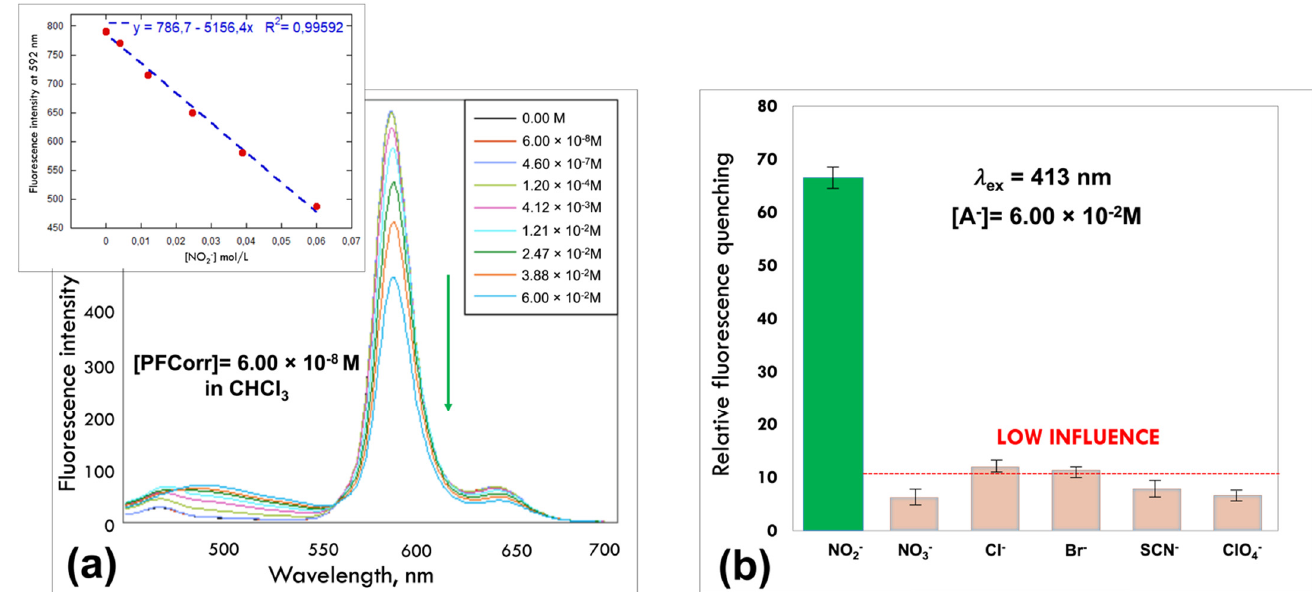
Figure 3. ( a ) The fluorescence response of 6 × 10 − 8 M PFCorr in CHCl 3 upon addition of increasing concentrations of NO 2 − ions. In the insert: linear regression curve of PFCorr fluorescence intensity quenching at 592 nm vs. [NO 2 − ], mol/L; ( b ) The tests on relative fluorescence quenching of PFCorr fluorescence at 580 nm in the individual anion solutions in concentration 6 × 10 − 2 M; 𝜆 ex = 413 nm.